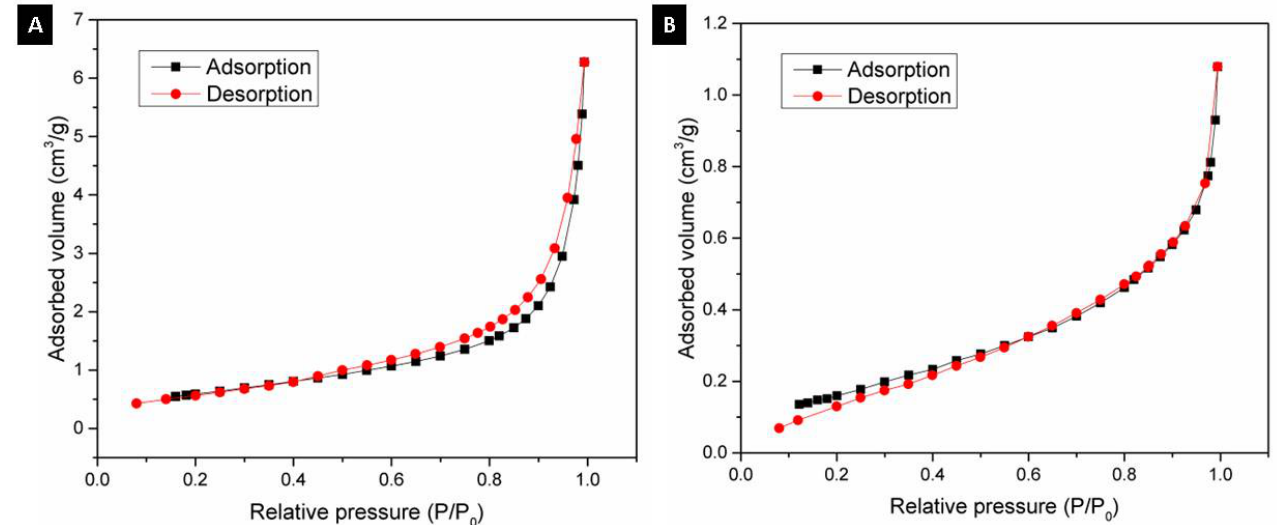
Figure 9. N 2 adsorption–desorption isotherm: ( A ) Alumina sphere treated at 1000 °C and ( B ) Alu-